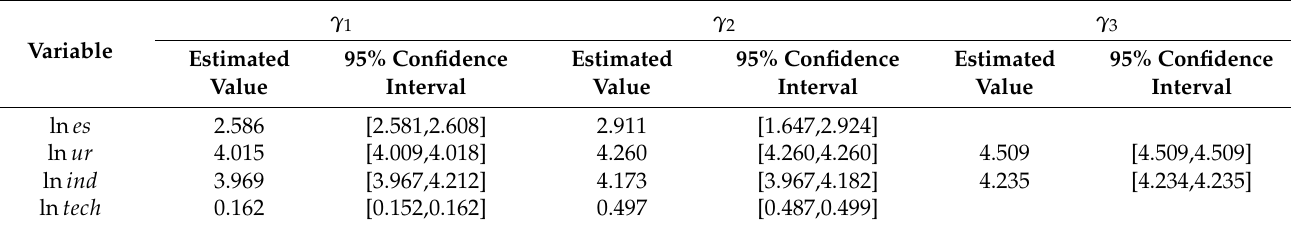
Table 6. Threshold estimates and confidence intervals.